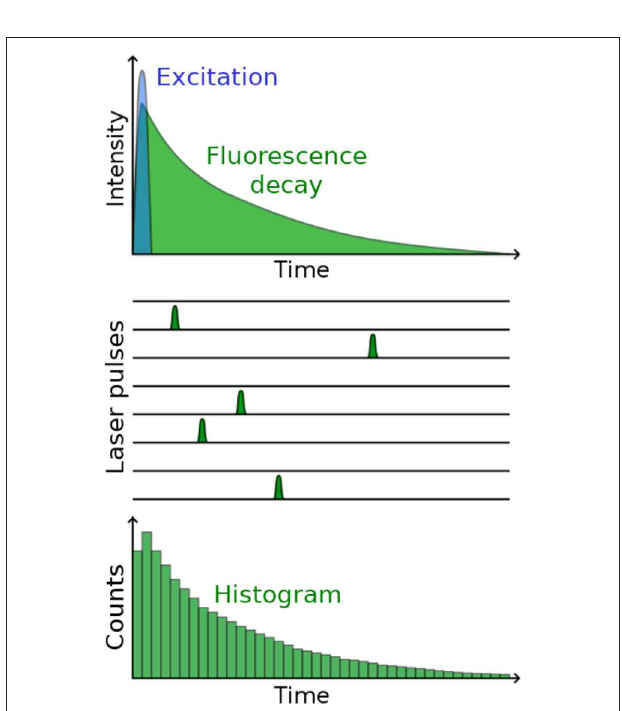
FIGURE 3 | Principle behind photon arrival timing for TCSPC. After repeatedly exciting the sample and timing the arrival of many fluorescence photons (schematically indicated in the middle), a histogram is built up that represents the fluorescence decay.